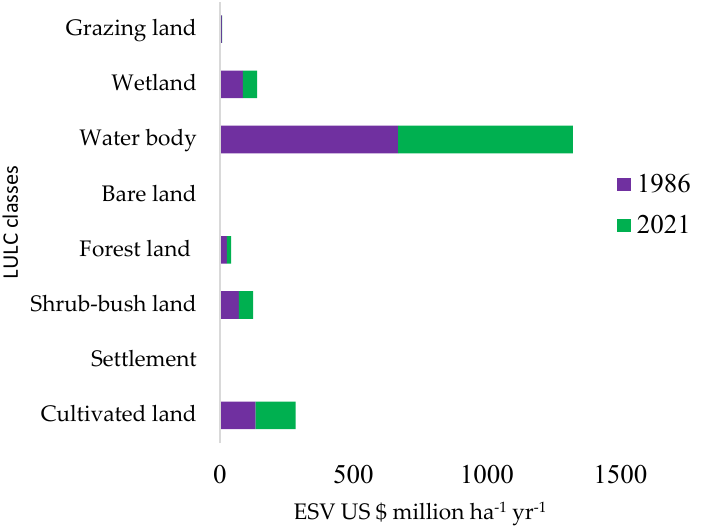
Figure 14. ESV from 1986 to 2020 in Chilalo mountain, Ethiopia (Source of data: Biratu et al. [71], but figure done by authors).